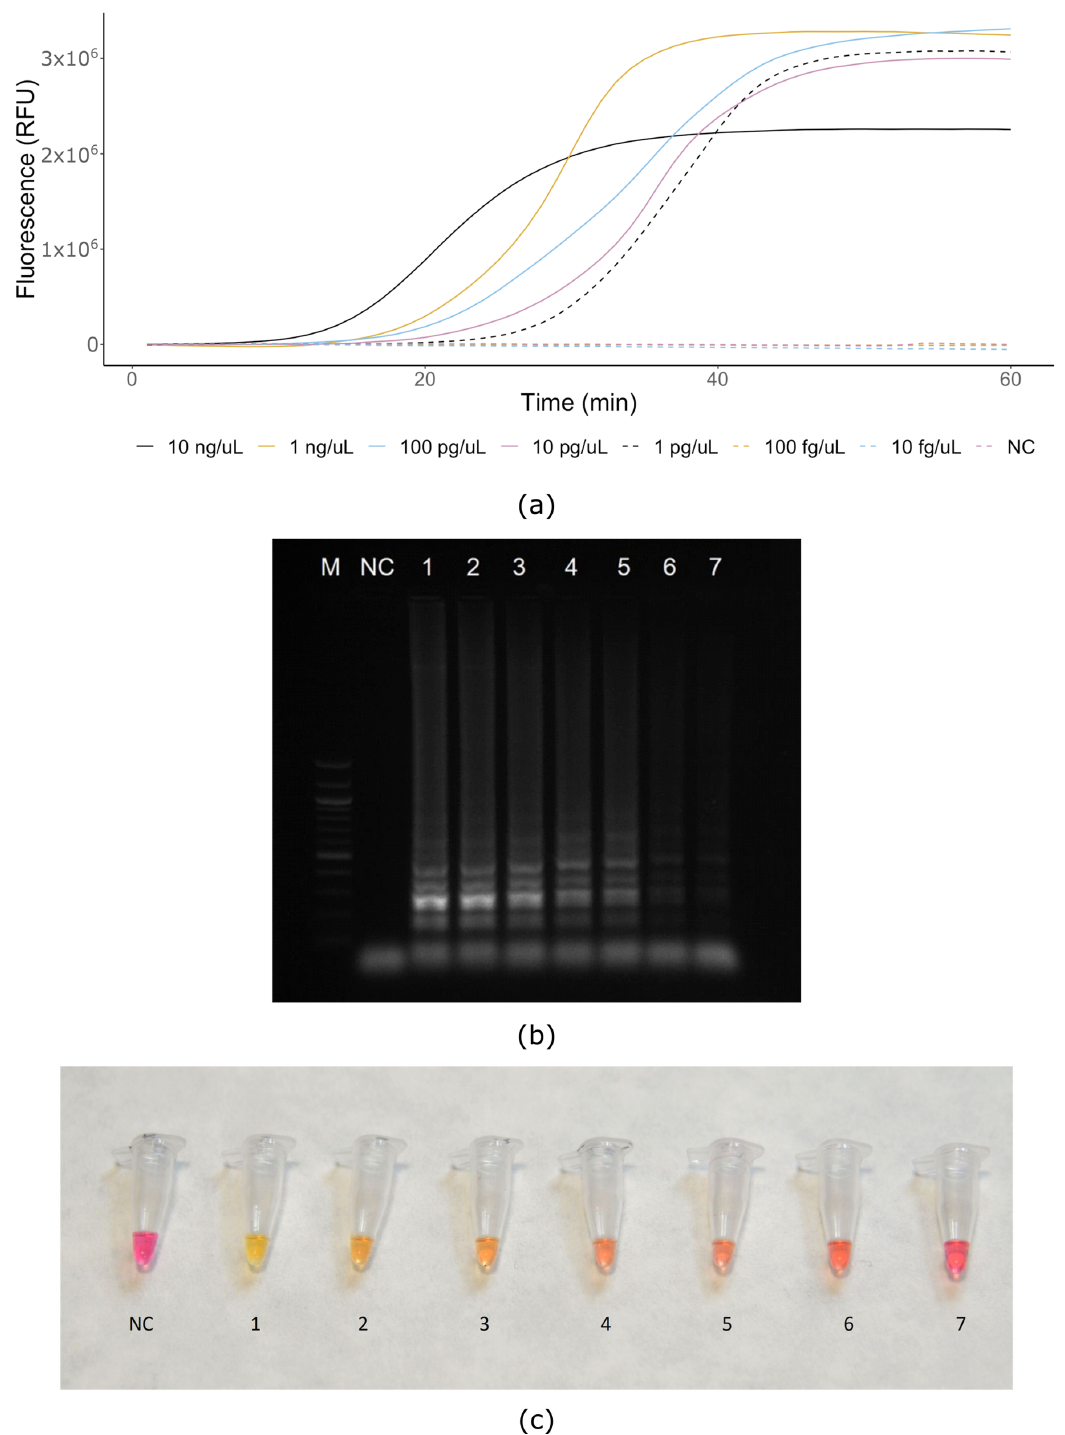
Figure 2. Serial 10-fold dilutions: ( a ) real-time LAMP assay (QuantStudio™ 6 Flex Real-Time PCR System); ( b ) gel electrophoresis of LAMP products confirms results of real-time LAMP; ( c ) Colorimetric Master Mix assay after 30 min reaction time; M—ladder 100 bp (NEB, UK), NC—negative control water, 1—10 ng/ μ L, 2—1 ng/ μ L, 3—100 pg/ μ L, 4—10 pg/ μ L, 5—1 pg/ μ L, 6—100 fg/ μ L, 7—10 fg/ μ L.